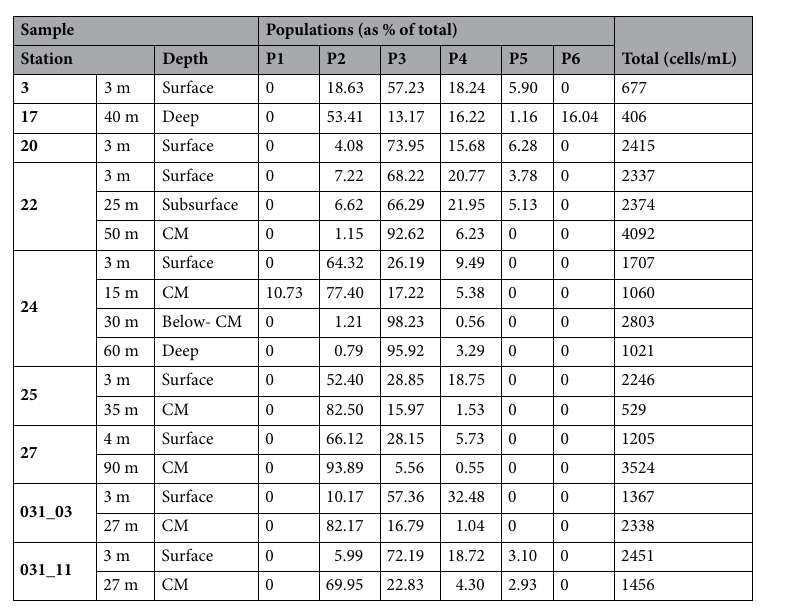
Table 1. Cell counts per population, as the proportion of the summed total cell density for all 6 gated populations. CM, chlorophyll maximum.